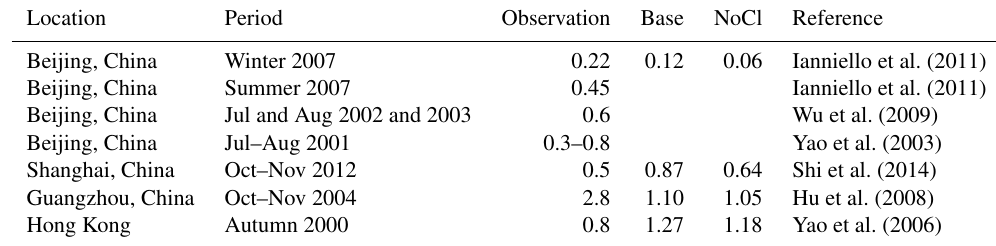
Table 3. A comparison of predicted HCl concentrations for the Base and NoCl experiments to observed data from literature ∗ . Location Period